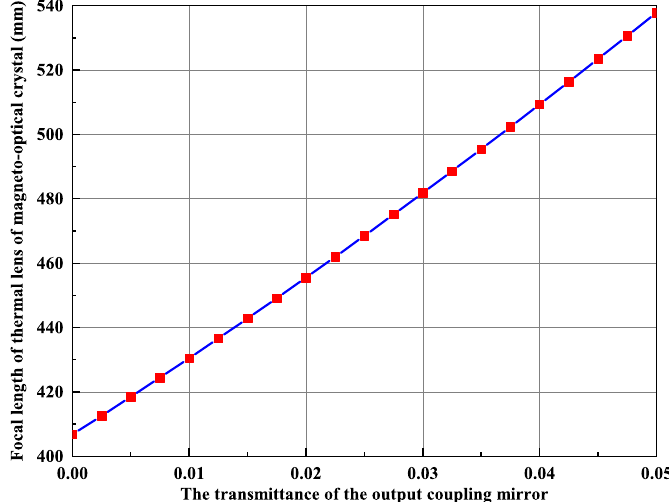
Figure 9. Focal length of thermal lens of magneto-optical